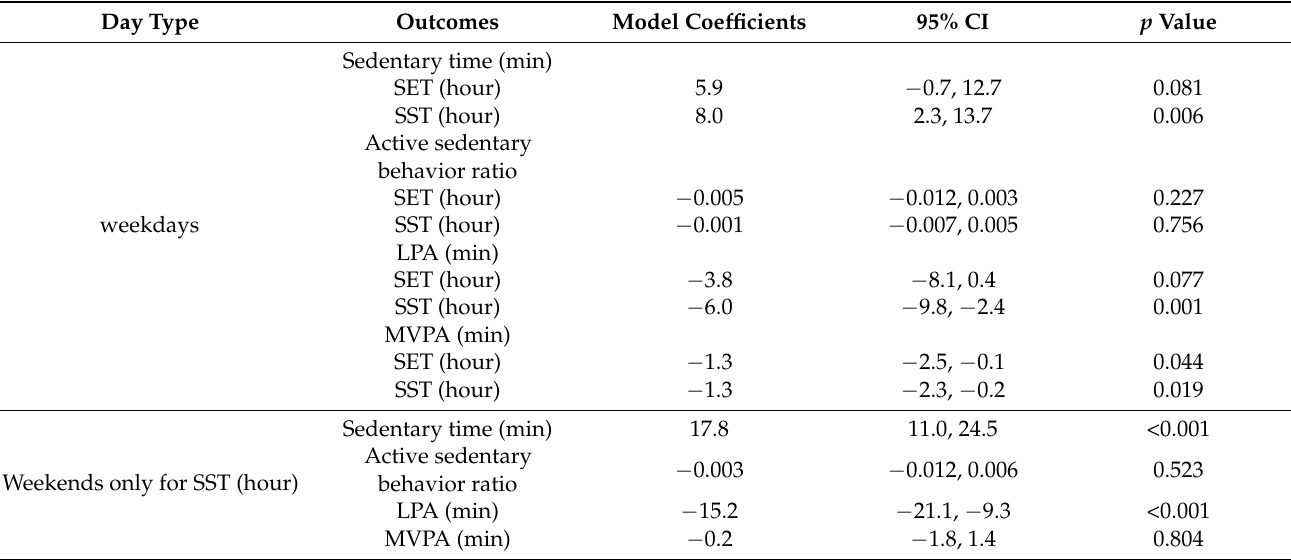
Table 4. Association between scheduled education time/self-study time and students’ physical activity